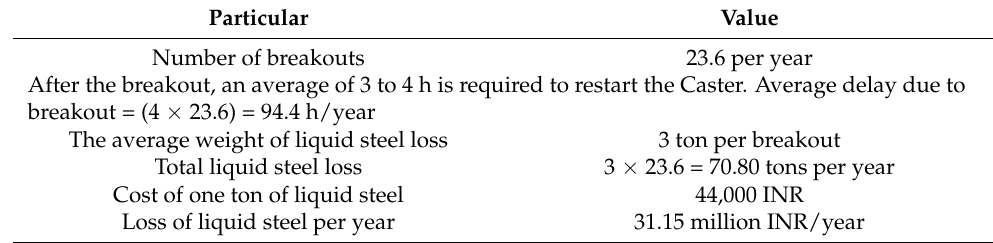
Table 1. Loss due to breakout. Figure 3. Pareto chart of causes of breakout.